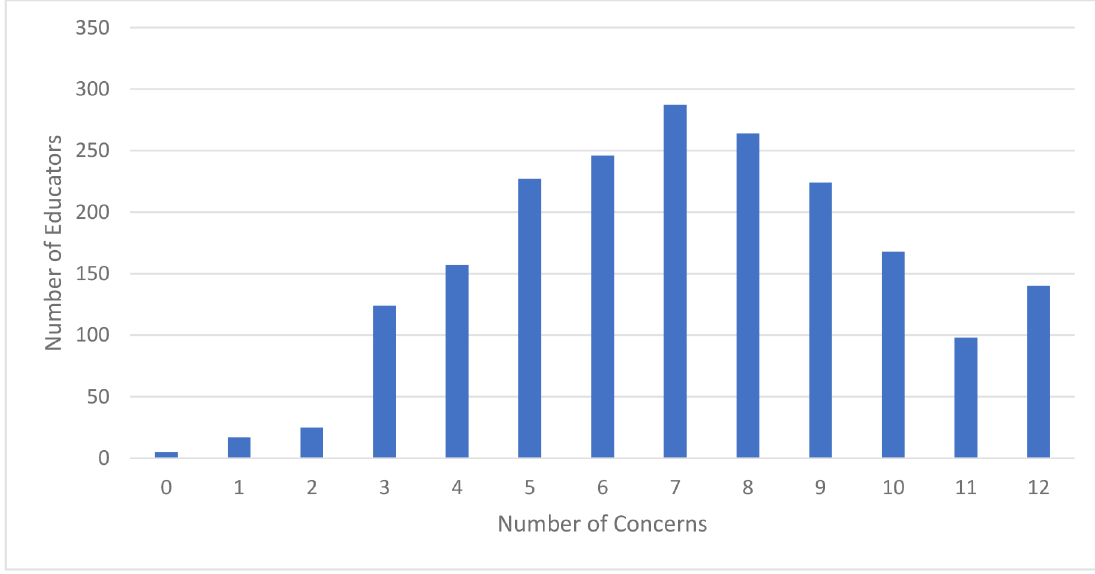
Figure 2: Number of educator-reported concerns regarding the return to school in September 2020 ( n = 1 , 982)